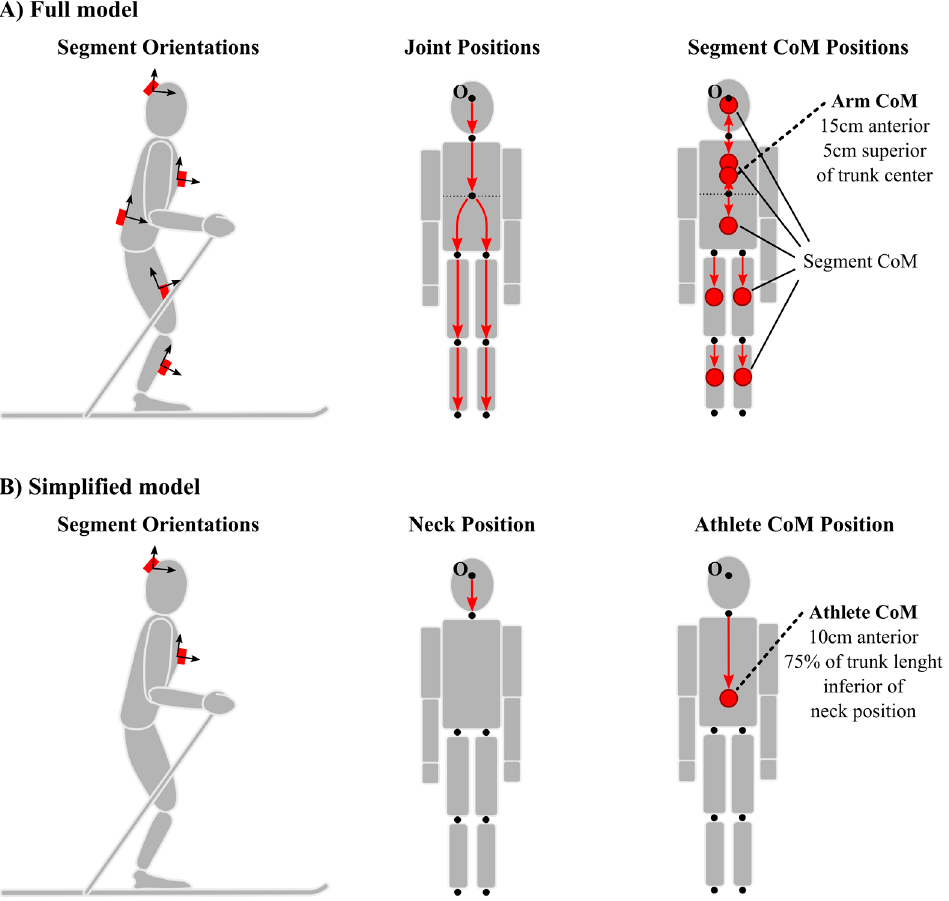
Figure 2. Kinematic chain used to compute the joint and segment CoM positions based on the segment orientations in the anatomical frame. ( A ) Full 3D body model based on all available inertial sensors; ( B ) simplified model based only on head and sternum inertial sensors.